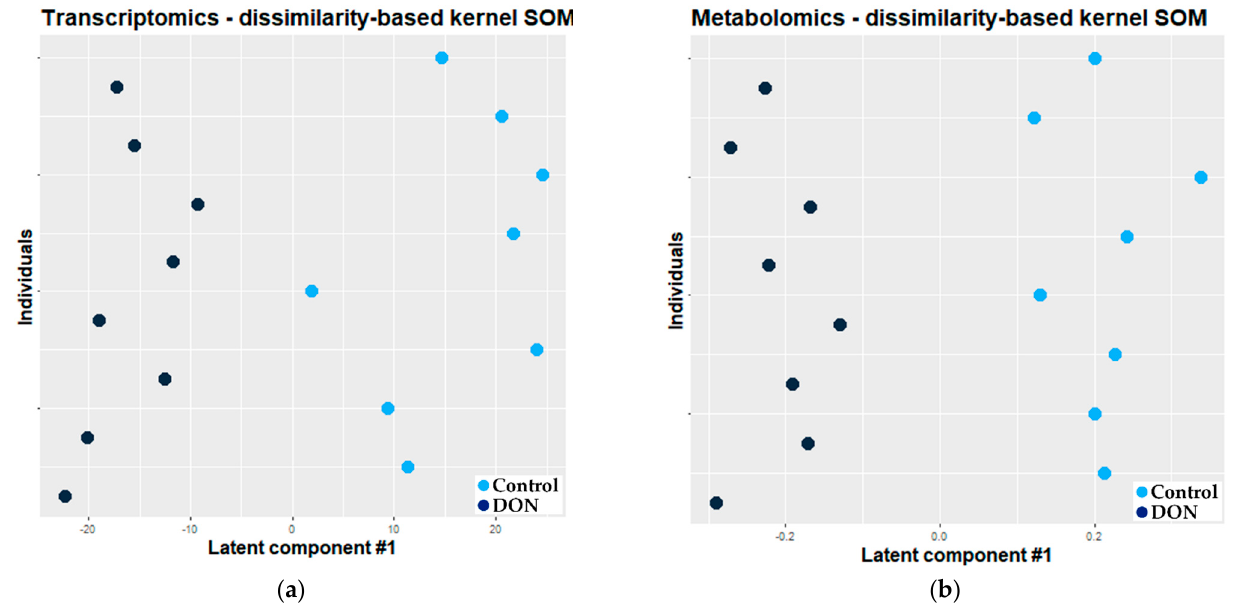
Figure 5. Projection of individuals along the first latent variable of the O2-PLS-DA model based on the features selected by dissimilarity kernel-based SOM (light blue dot: control, n = 8; dark blue dot: exposed, n = 8). Each dot corresponds to an individual. ( a ) Transcriptomic dataset; ( b ) metabolomic dataset. Table 1. Metabolic pathways significantly enriched in DON-exposed intestinal